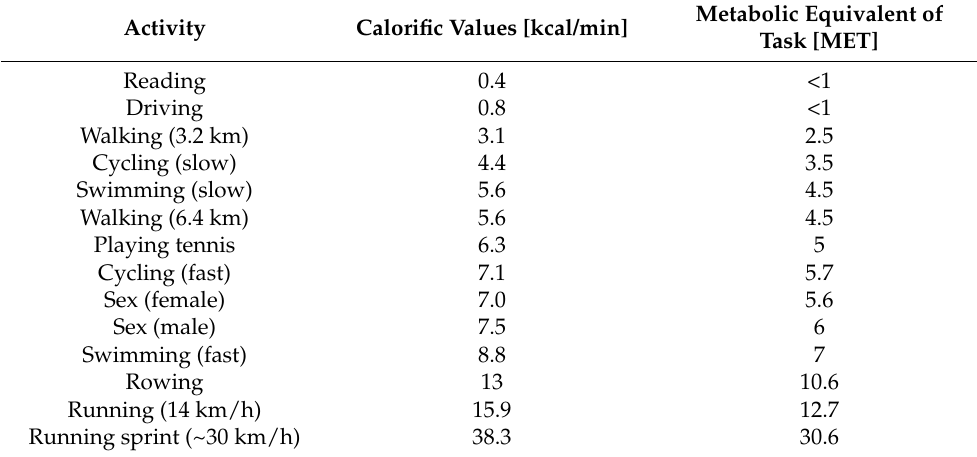
Table 2. Metabolic Equivalent of Task for different